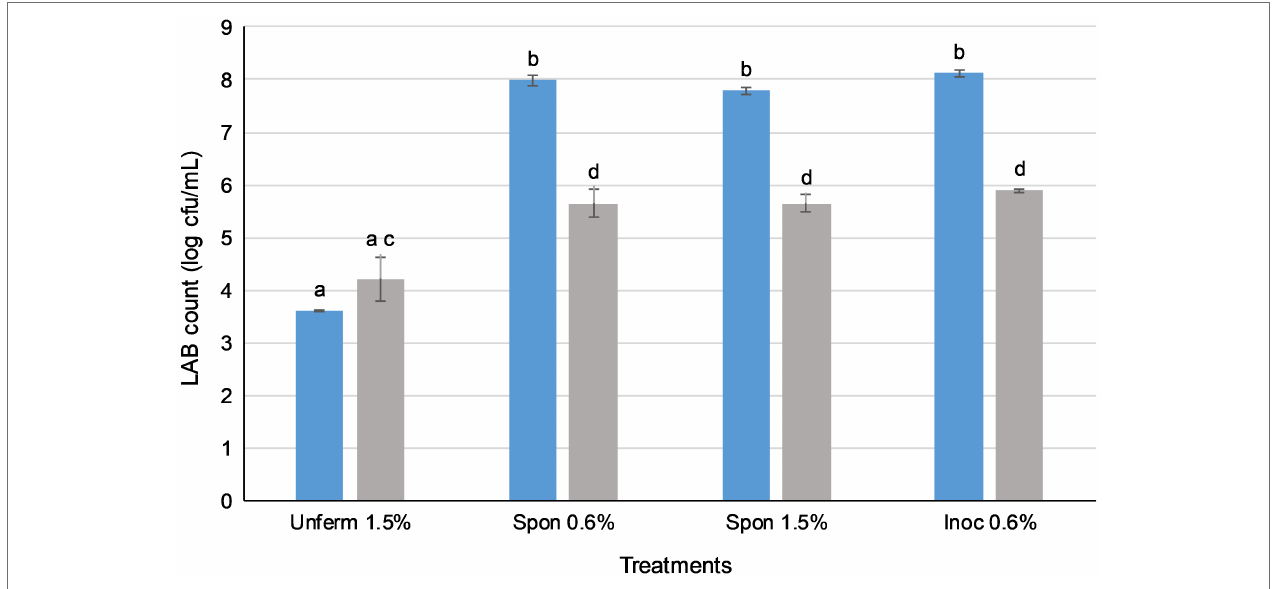
FIGURE 3 | Lactic acid bacteria in sauerkraut survive simulated oral, gastric, and small intestinal conditions. ( ) Total LAB plate counts before in vitro digestion; ( ) total LAB plate counts after simulated GI conditions. The results were expressed as mean standard deviation ( n = 3) for each treatment group. Means with the same letter are not significantly different ( p < 0.05).